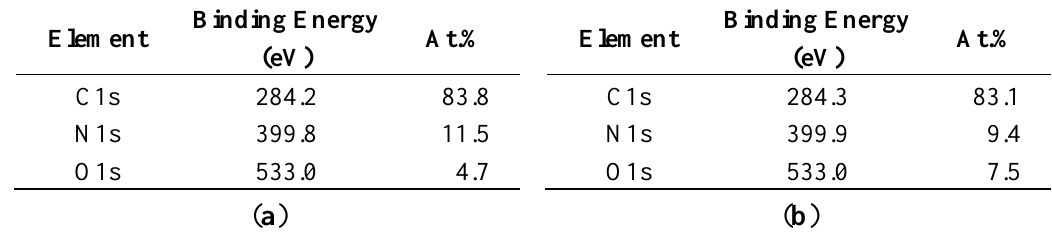
Table 1. Surface element content of CNTs pellets treated under same treatment plasma parameters and conserved under atmospheric pressure ( a ) in argon or ( b )